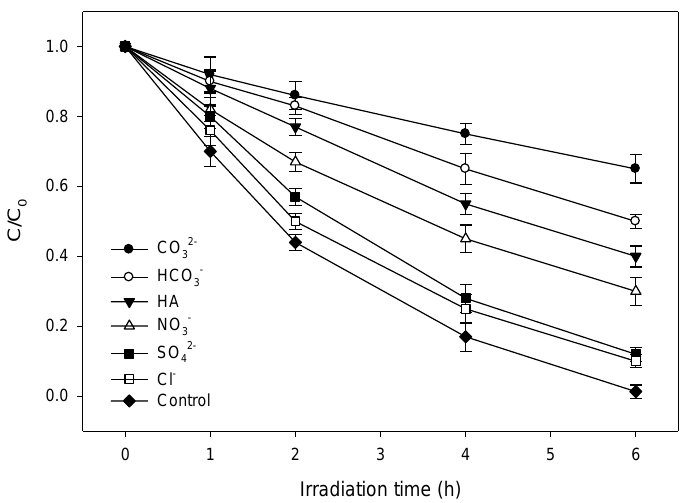
Figure 6. E ff ect of humic acid and inorganic anions (CO 32 − , HCO 3 − , NO 3 − , SO 42 − , and Cl − ) on the Figure 6. Effect of humic acid and inorganic anions (CO 32− , HCO 3− , NO 3− , SO 42− , and Cl − ) on the SSLA-TiO 2 / S 2 O 82 − / H 2 O 2 photocatalysis of lindane. [lindane] 0 = 1.0 µ M; mass of TiO 2 film = 9.02 mg; SSLA-TiO 2 /S 2 O 82− /H 2 O 2 photocatalysis of lindane. [lindane] 0 = 1.0 µM; mass of TiO 2 film = 9.02 mg; thickness of TiO 2 film = 1.02 µ m; area of TiO 2 film = 3750 mm 2 ; [humic acid] 0 = 1 mg / L; [inorganic thickness of TiO 2 film = 1.02 µm; area of TiO 2 film = 3750 mm 2 ; [humic acid] 0 = 1 mg/L; [inorganic ions] 0 = 1 ions] 0 = 1 mM.